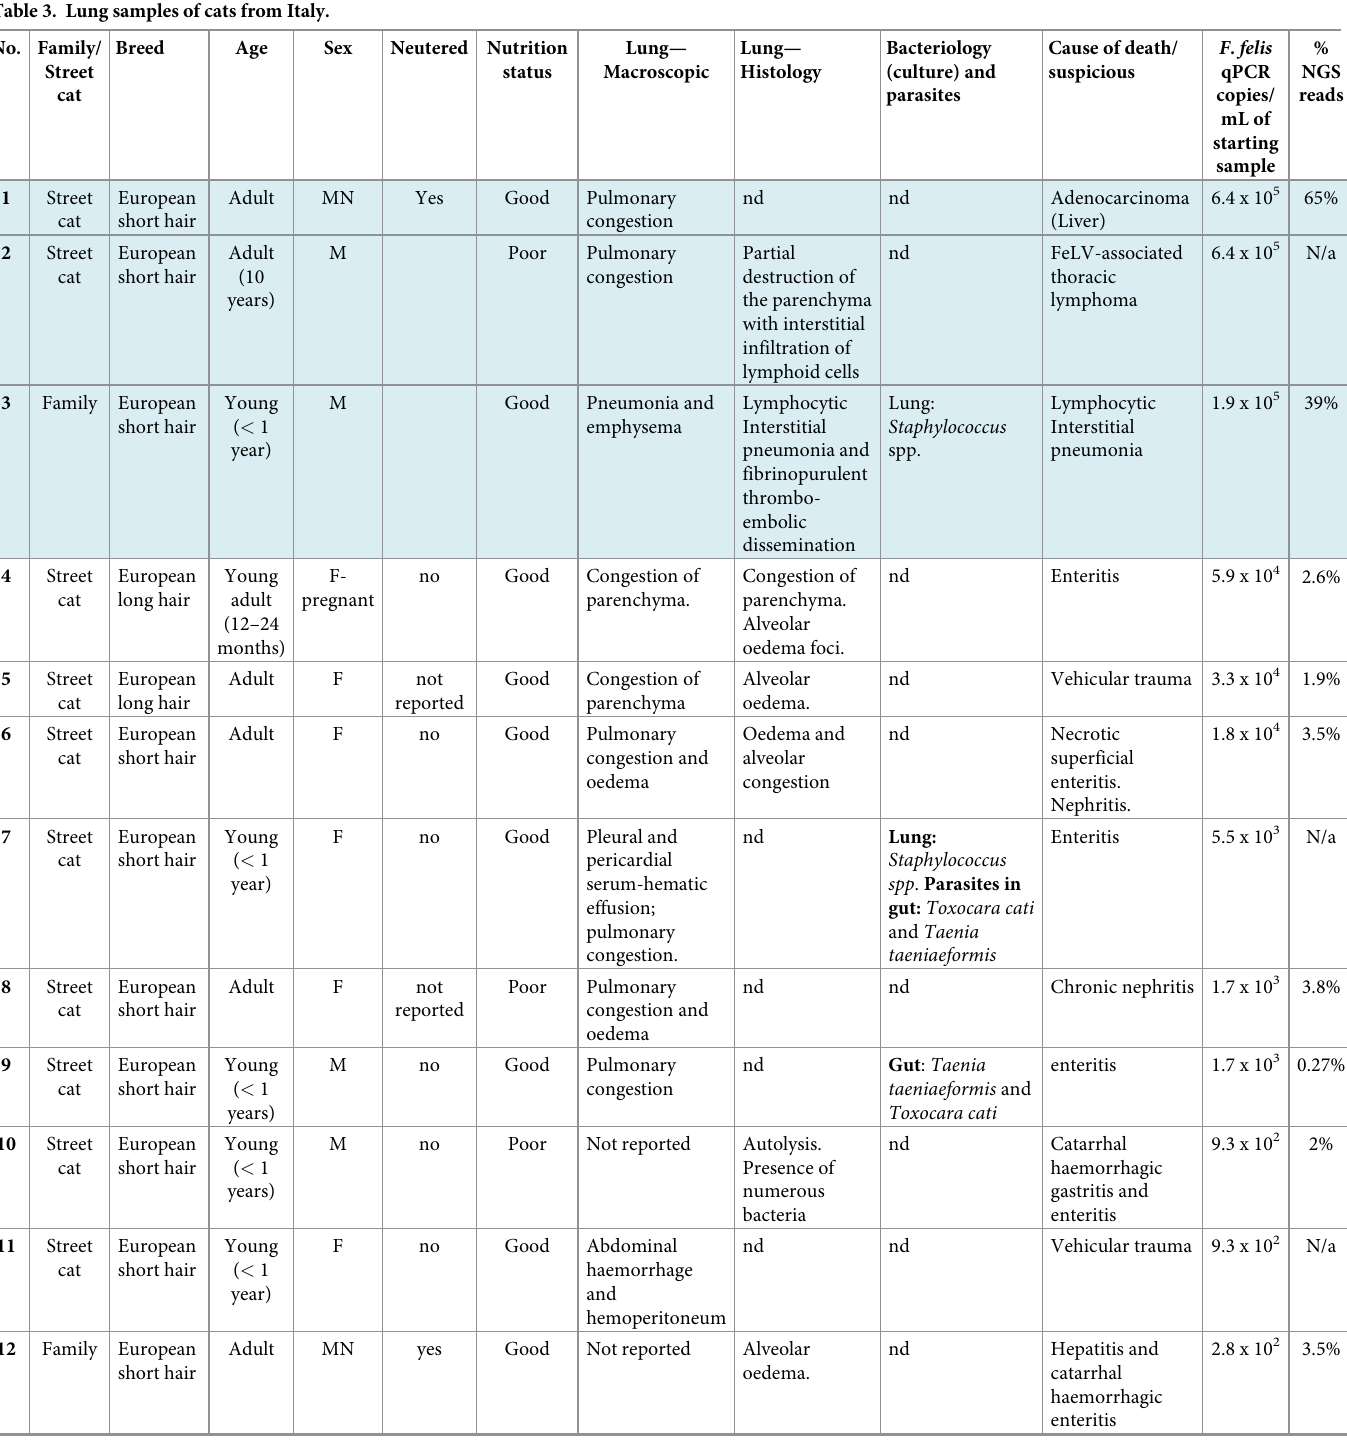
Table 3. Lung samples of cats from